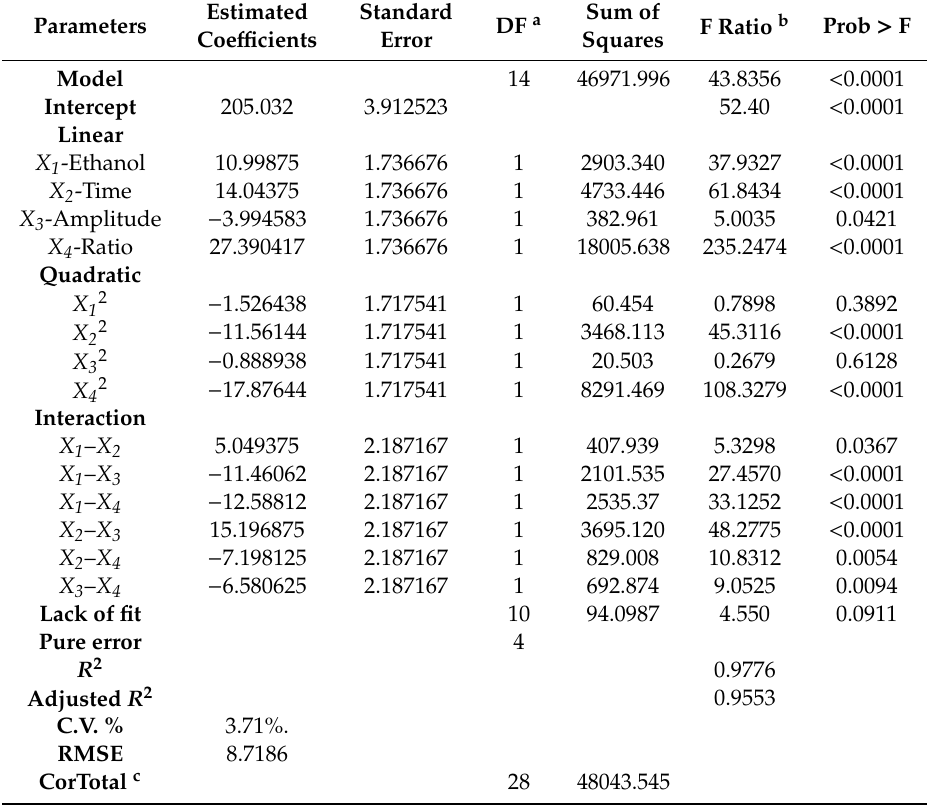
Table 2. Estimated regression coe ffi cients for the quadratic polynomial model and analyzes of variance (ANOVA) for the experimental